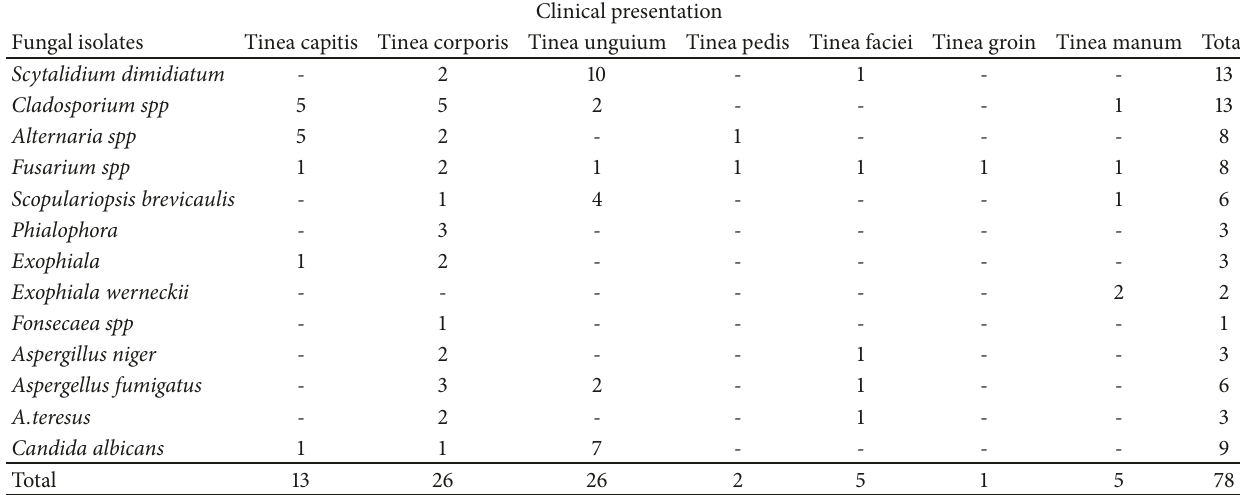
Table 5: Frequency and distribution of non-dermatophyte fungi in relation to clinical manifestations. Clinical